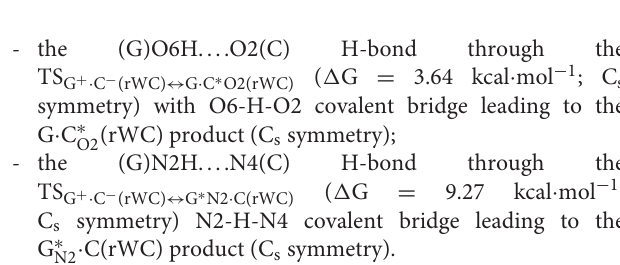
FIGURE 8 | Geometric structures of the 9 key points describing the evolution of the IV. G* ′ the B3LYP/6-311 G(d,p) level of theory in vacuo (see Table 6 ). For more detailed designations see Figure 2 ++